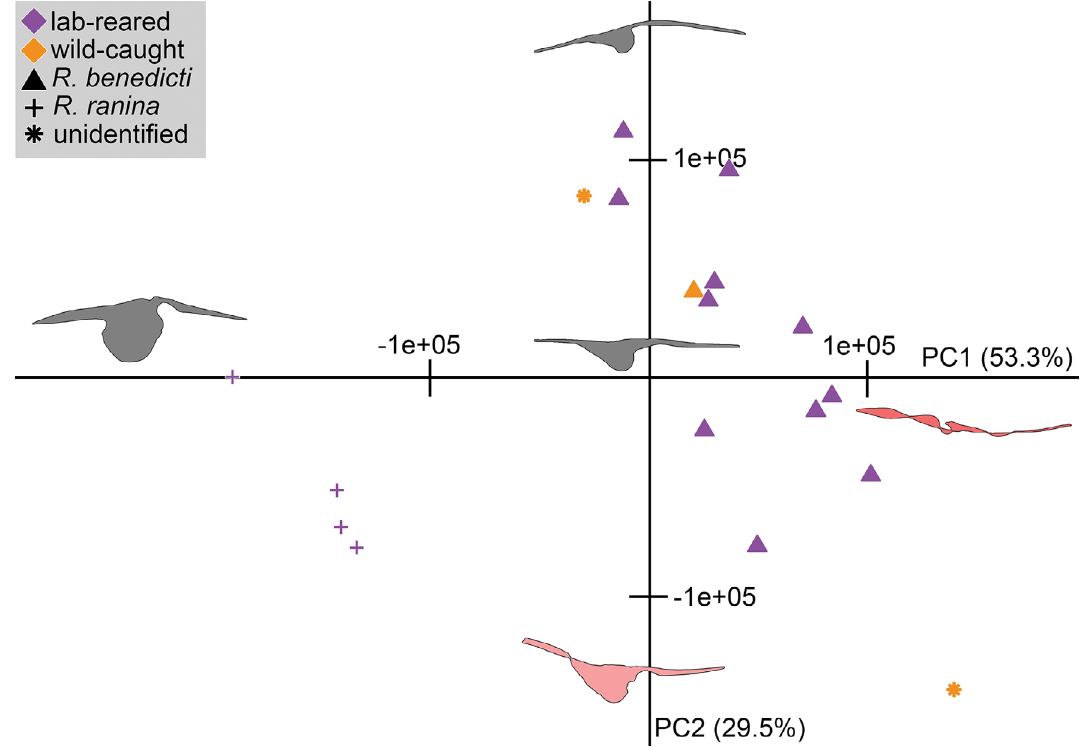
Figure 6. Plot of principal components from the PCA on the SHAPE analysis of shield outlines of Raninidae. PC1 and PC2 of the lateral analysis plotted against each other. Shapes included are from graphical component loadings and depict the mean shape of the principal component and +/-2 standard deviations of the mean shape. Color coding: dark grey: possible shapes of the lateral analysis; red: impossible shapes of the lateral